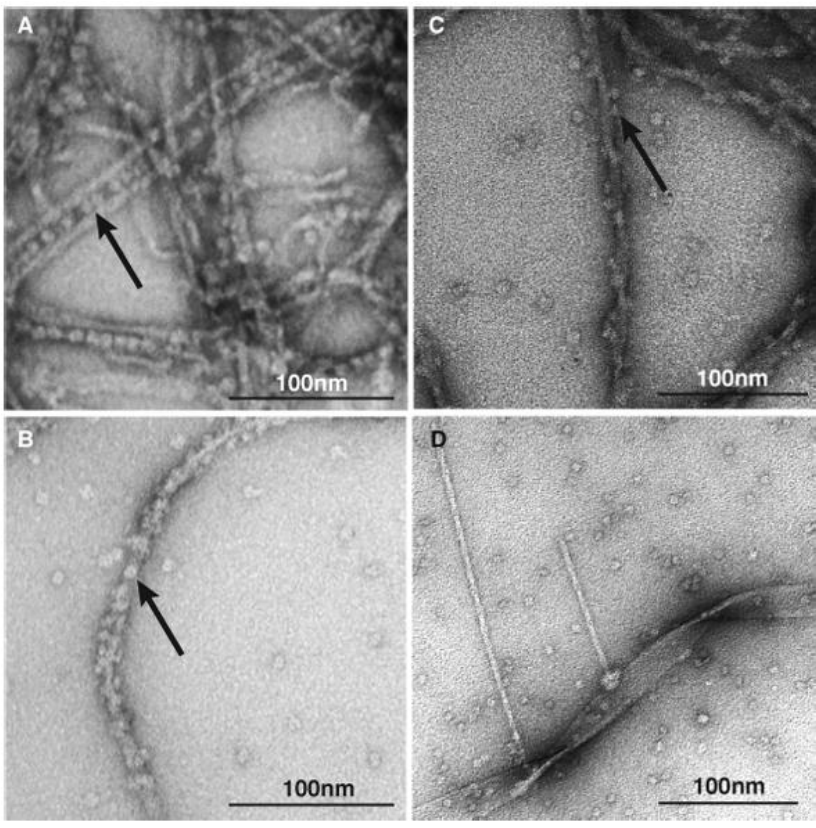
FIGURE 3 . Comparison of HEC binding to human IAPP 1-37 (A), human Aβ 1-42 (B), human PrP 118-135 (C), and PepA (D) fibrils. The human IAPP 1-37, Aβ 1-42, and PrP 118-135 fibrils all showed binding to catalase (example indicated by arrow in A–C). The PepA showed a polymorphic mixture of fibrils, ribbons, and sheet-like structures, none of which showed catalase binding. The scale bars indicate 100